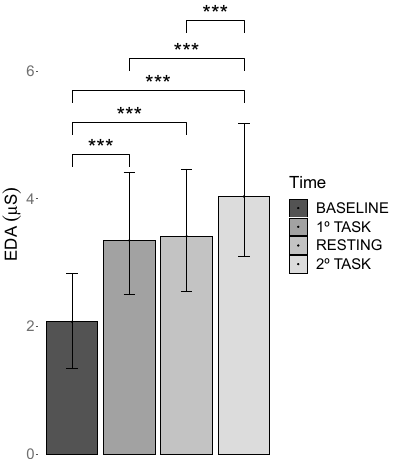
Figure 10. Mean electrodermal activity (EDA) as a function of time. *** p < 0.001.